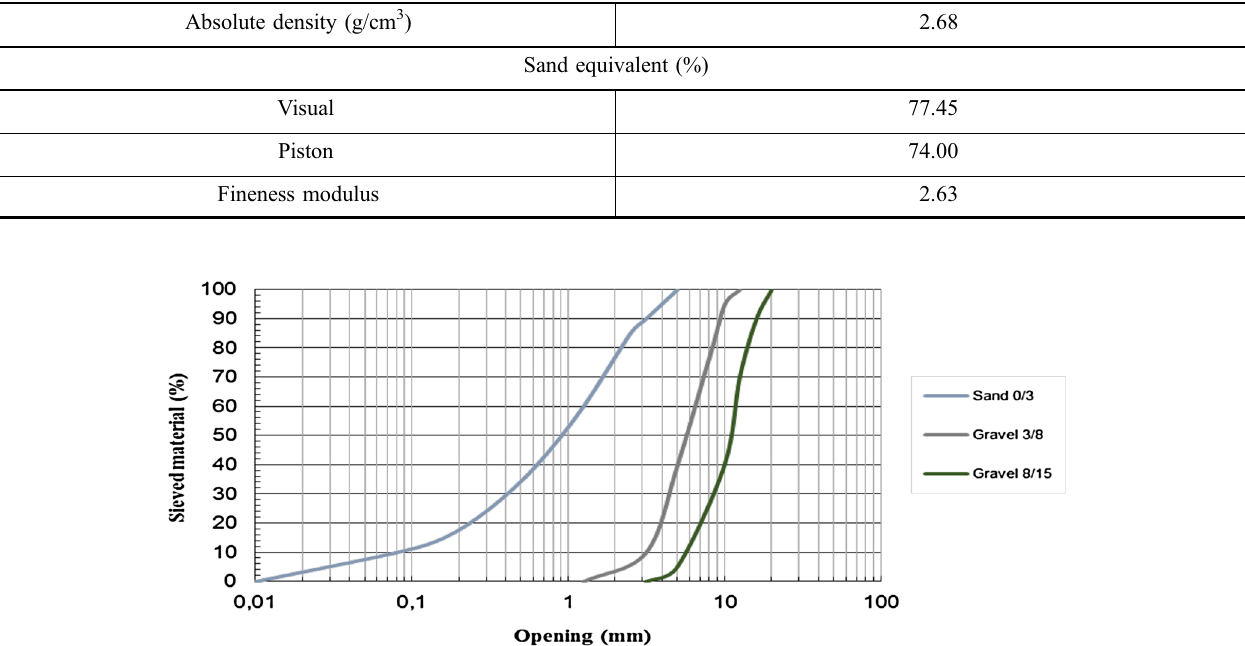
Table 4 Physical characteristics of the quarry sand.